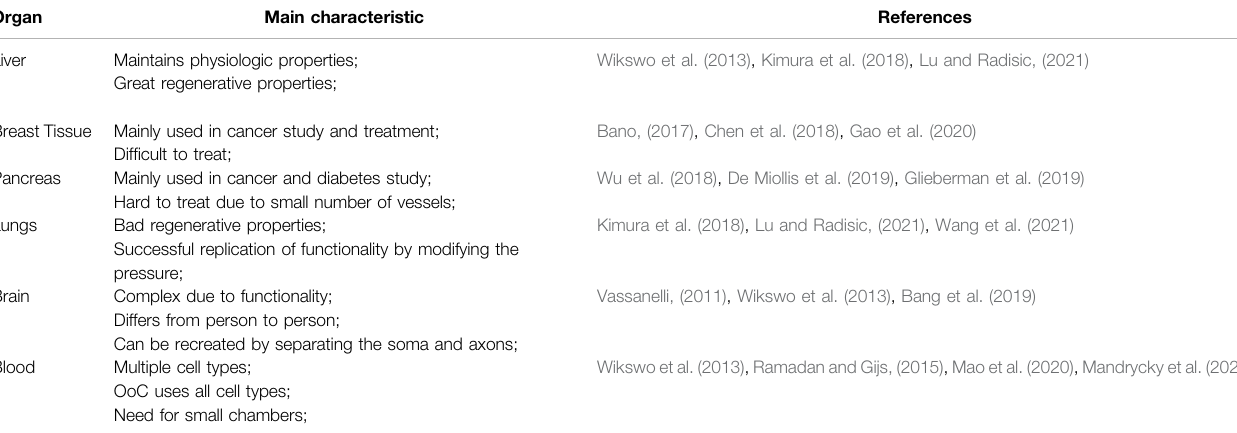
TABLE 1 | Summary for organs that have been recreated using organ-on-a-chip